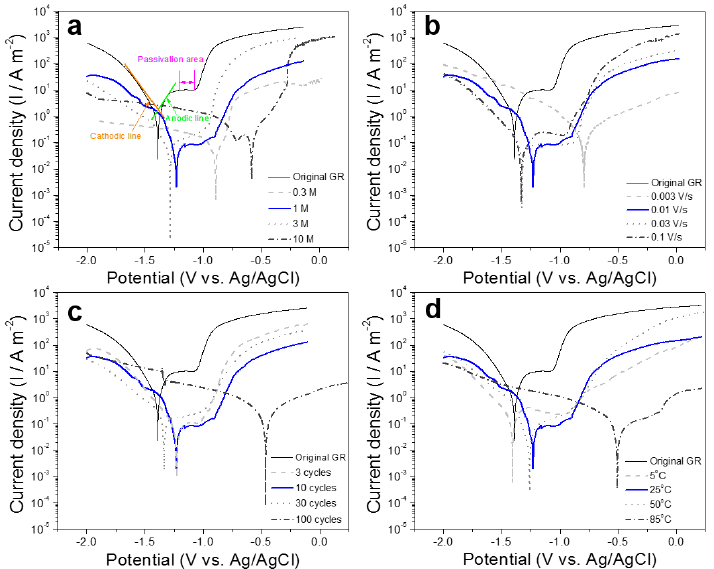
Figure 8. Potentiodynamic polarization curves of samples tested in 3.5 wt.% NaCl solution under different experimental parameters: ( a ) solution concentrations; ( b ) sweep rates; ( c ) cycle numbers; ( d ) reaction temperatures.